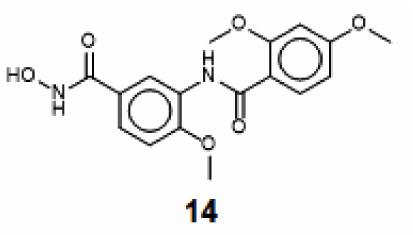
Figure 10. Structure of the poorly predicted molecule by Model 97